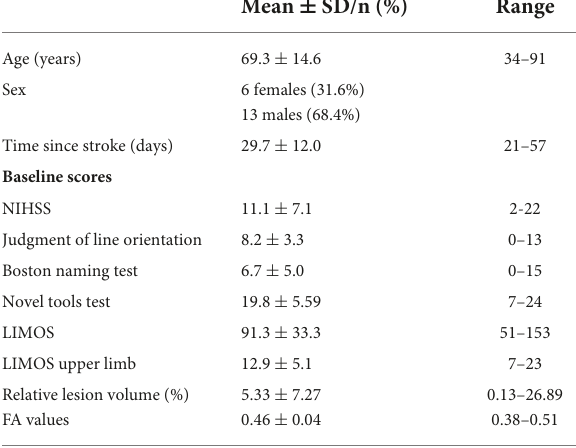
TABLE 1 Patient